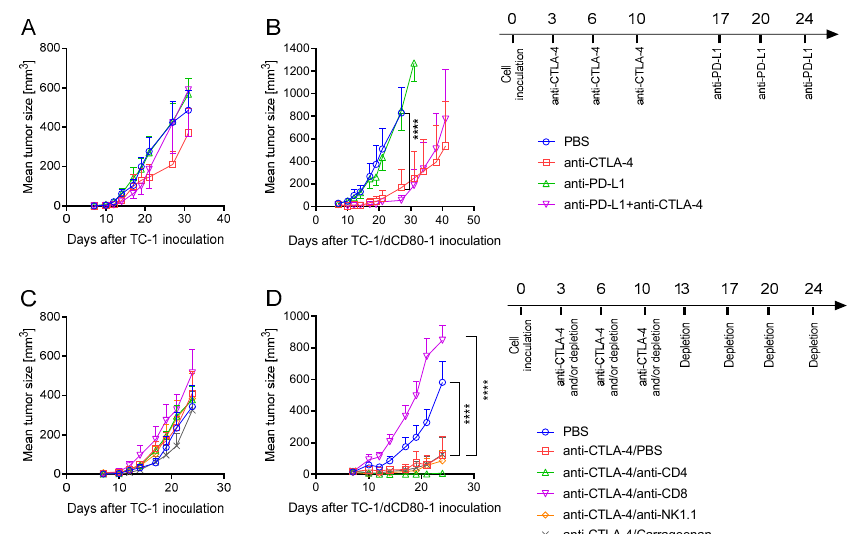
Figure 4. Immunotherapy by immune checkpoint blockade. Mice ( n = 5) bearing either TC-1- ( A ) or TC-1/dCD80-1-induced tumors ( B ) were treated with anti-cytotoxic T-lymphocyte antigen 4 (CTLA- 4), anti-programmed cell death ligand 1 (PD-L1), or a combination of both antibodies. The cells involved in the anti-tumor effect of CTLA-4 blockade were analyzed by depletions of CD4 + , CD8 + , NK1.1 + cells, or macrophages in mice bearing TC-1-induced tumors ( C ) or TC-1/dCD80-1-induced tumors ( D ). Phosphate-buffered saline (PBS) was used as the control. Statistical analysis indicates a comparison with the anti-CTLA-4/PBS group. Bars indicate ±SEM; **** p < 0.0001.